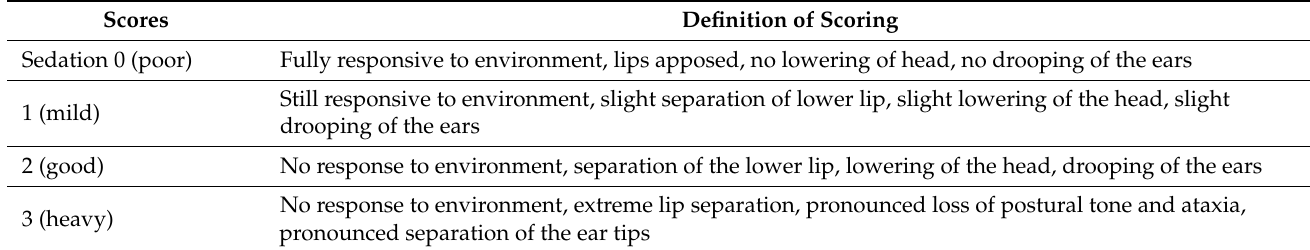
Table 1. Scoring system used to assess depth of sedation in 8 mules before ovariectomy (from Vullo et al., 2017 [22]). Scores Definition of Scoring Sedation 0